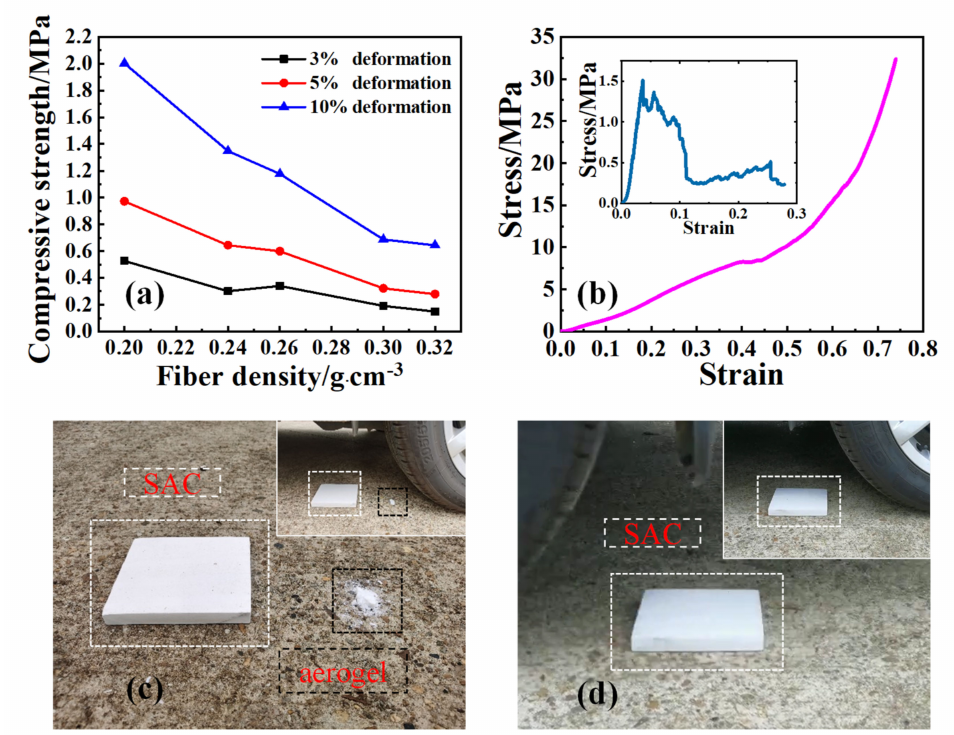
Figure 4. ( a ) Compressive strength as functions of the fiber density of SAC, ( b ) compressive stress– strain curve of SAC and aerogel (inset), ( c ) photos of the first car pressure test, and ( d ) photos of the second car pressure